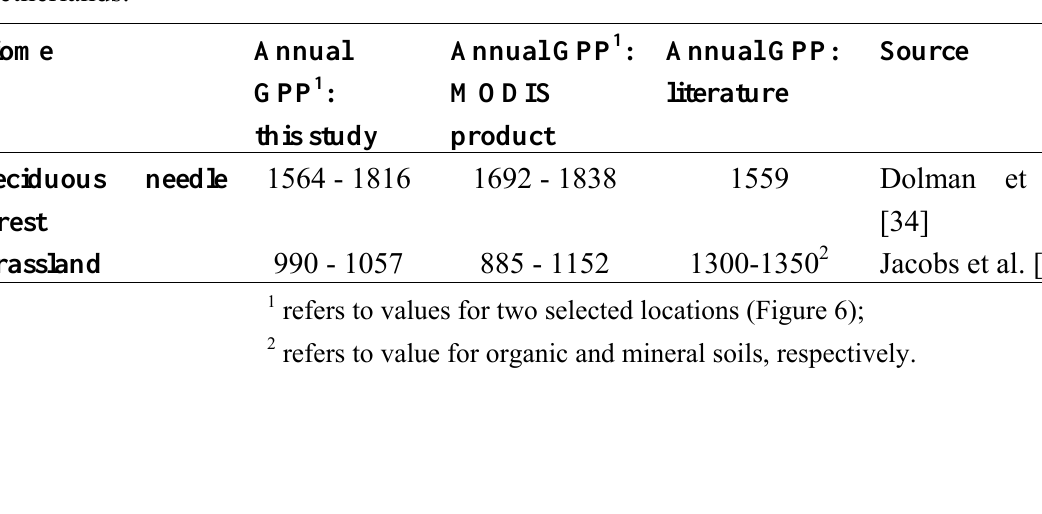
Table 2. Comparison of annual GPP (gC·m -2 ·day- 1 ) estimates for different biomes in the